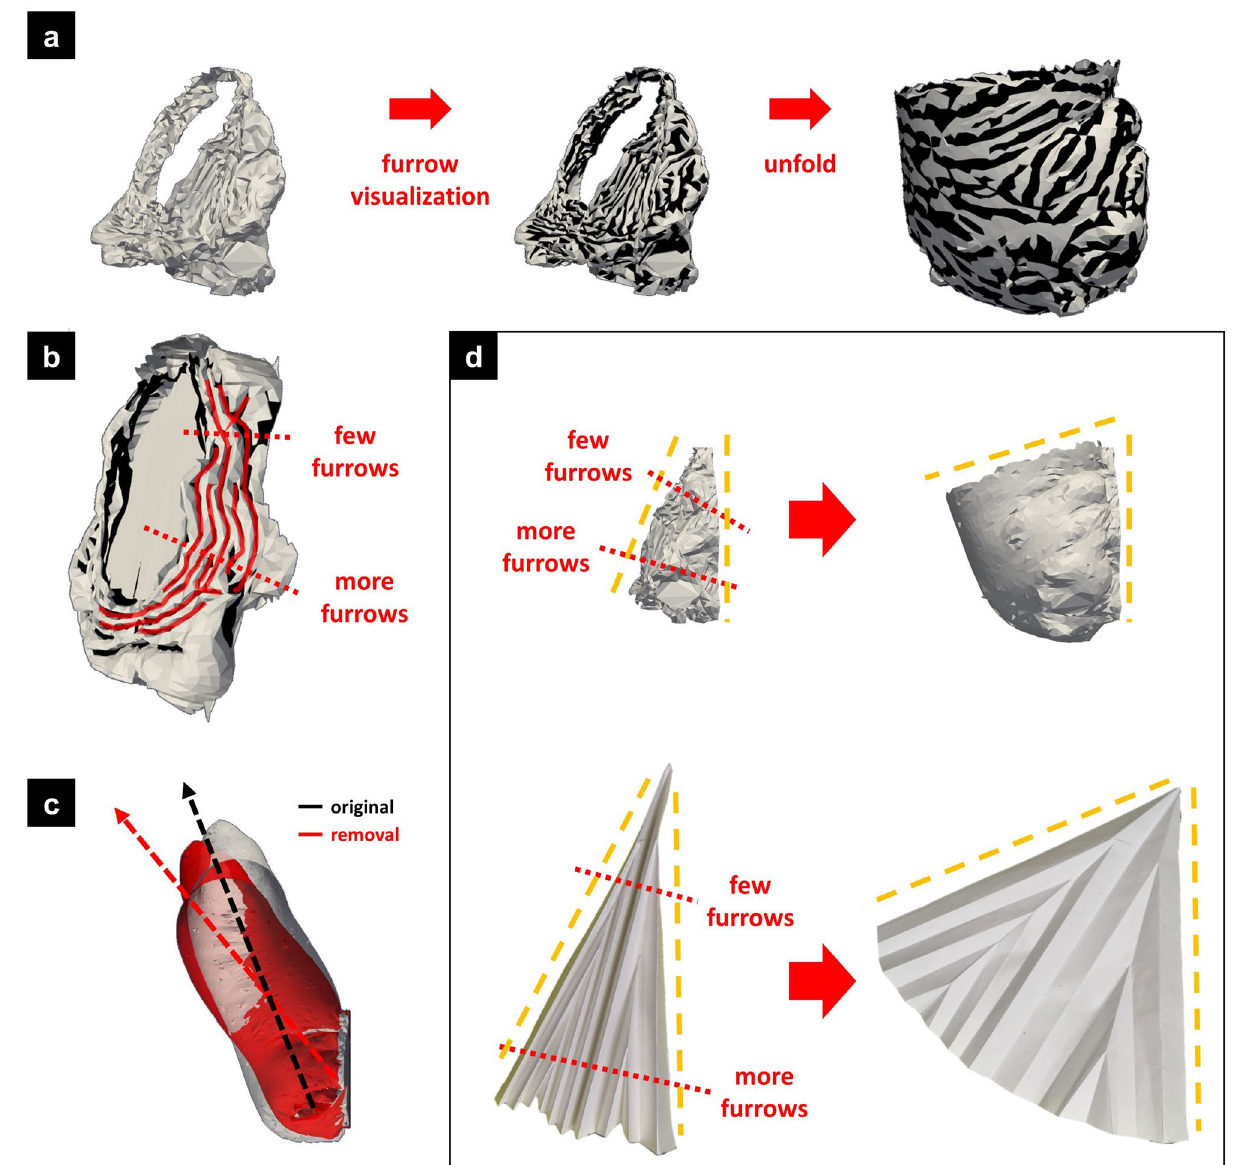
Figure 3. The furrow pattern in the base turns the horn dorsally. ( a , b ) Furrow visualization of the base. The unfolding simulation was performed after furrow visualization ( a ). The visualization showed that more furrows were arranged on the ventral side than on the dorsal side. ( b ) Simplest example of the furrow pattern. ( c ) Furrow removal analysis of the base. When the furrows were made shallower, the dorsally turning ratio became smaller (red arrow) than the original (black arrow). ( d ) Contribution of the furrow pattern to transformation. Since the ventral side had more furrows than the dorsal side, the enlargement ratio of the ventral side was much bigger than that of the dorsal side. The difference turned the orientation of the horn dorsally. The upper lane shows the transformation of the base and the lower lane shows the transformation of the origami Next, we observed the stalk region using a CT scan (Fig. 4c). Because the shape of the unfolded stalk was a cyl- inder, the furrows in this area did not create a specific three-dimensional shape (because the Gaussian curvature of a cylinder is zero) but contributed to the elongation of the cylinder along the proximodistal axis. Therefore, the direction of folding in most of the stalk region was parallel to the circumference of the cylinder (Fig. 4e). However, if the direction of every fold was parallel to the circumference of the cylinder, like an accordion (Sup- plementary Figure 4a), the unfolded shape was still wavy (Supplementary Figure 4b). Thus, on the ventral and dorsal sides of the stalk (especially on the ventral side), two more complicated patterns were observed. One consisted of wavy folds (Fig. 4d) and the other consisted of zigzag folds (ridges/valleys alternately coming from the left and right side, Fig. 4f). The zigzag fold, also known as a Yoshimura fold 10 , is a famous folding pattern that inevitably arises when a cylinder-like plane is compressed in the axial direction (Fig. 4h). Because the stalk is surrounded by the cap and base, the growth of a cell sheet in the axial direction is thought to result in relative